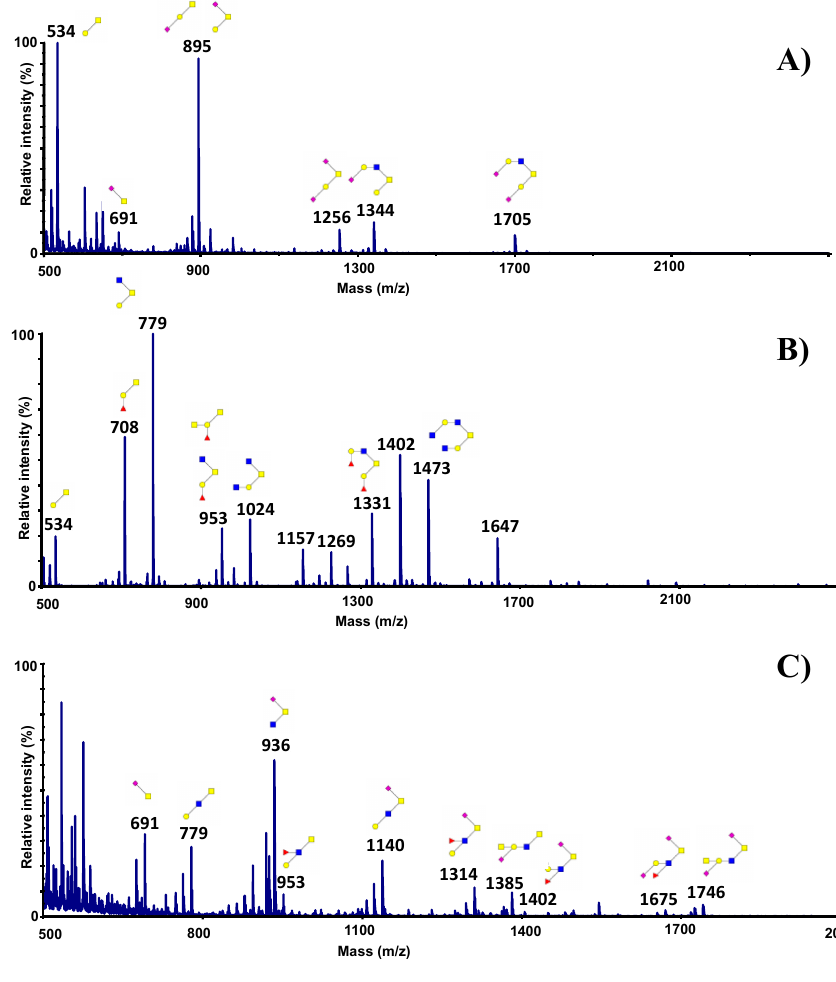
Figure 4. MS spectra of permethylated O -glycans isolated from mucins purified from HT29-MTX ( A ); from pig gastric mucins ( B ) and from human colonic mucins ( C ). Mucin O -glycans were released from the protein backbone and permethylated before analysis by MALDI-TOF mass spectrometry in the positive ion mode [M+Na] + . Monosaccharide symbols are used according to the Consortium for Functional Glycomics (CFG) nomenclature. Key: fucose (red triangle), GlcNAc (blue square), sialic acid (purple diamond), galactose (yellow circle), GalNAc-ol (yellow square) and sulfate residue (S). Note that for simplified comprehension, only the structure corresponding to the major isomer was drawn on the MS spectrum of PGM. Other isomers with the same monosaccharide composition might be present.